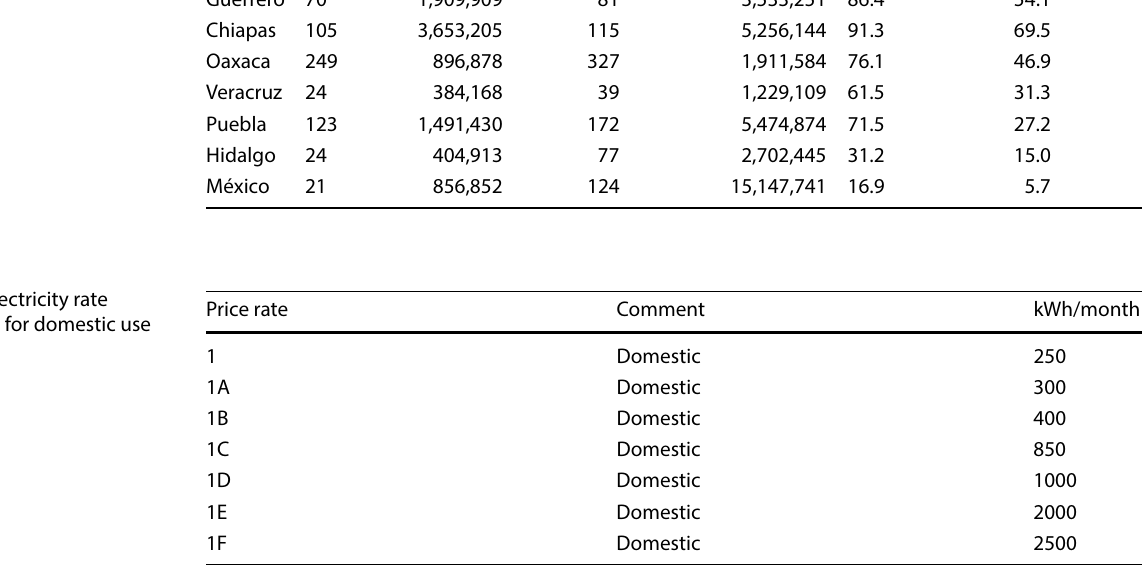
Population IM > 0 Municipalities Population Municip. with State Munici- palities IM > 0